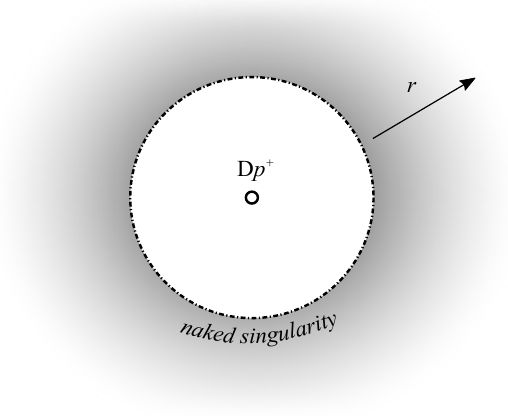
Figure 6 . Negative branes from the perspective of the exotic string theory living within the bubble. From this viewpoint, they are positive tension